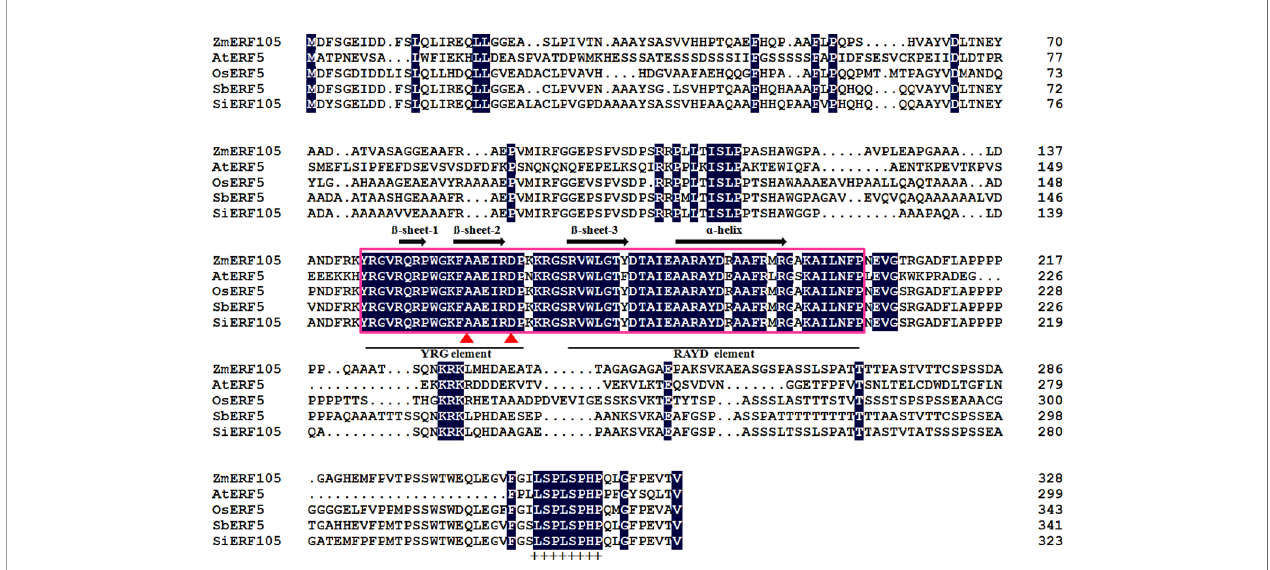
FIGURE 1 | Conserved motifs of the ZmERF105 protein sequence in alignment with other ERF transcription factors. The sequence alignment was performed using DNAMAN software. The AP2 DNA binding domain is indicated by pink box. The one a -helix and three b -sheets are marked above the corresponding sequences. The YRG and RAYD elements are indicated below the alignment. The conserved alanine and aspartic acid residues in the AP2 domain are marked by red triangles. A conserved LSPLSPHP motif is marked by ‘‘ + ’’ . AtERF5 (NP568679) is derived from Arabidopsis thaliana , OsERF5 (XP015624058) is derived from Oryza sativa , SbERF5 (XP021315889) is derived from Sorghum bicolor , and SiERF105 (XP004953326) is derived from Setaria italica